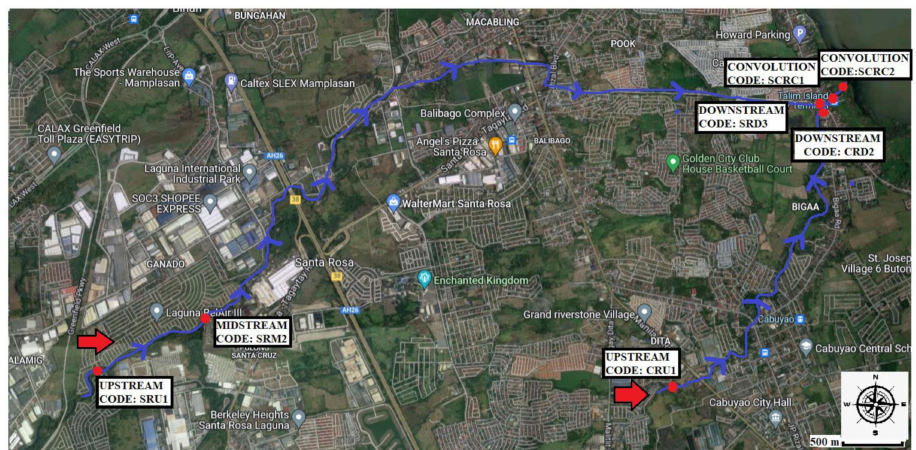
Figure 1. Water quality measurements and collection were done from seven sampling locations in SR and CR. The red arrow represents the water flow from upstream to downstream of both rivers.